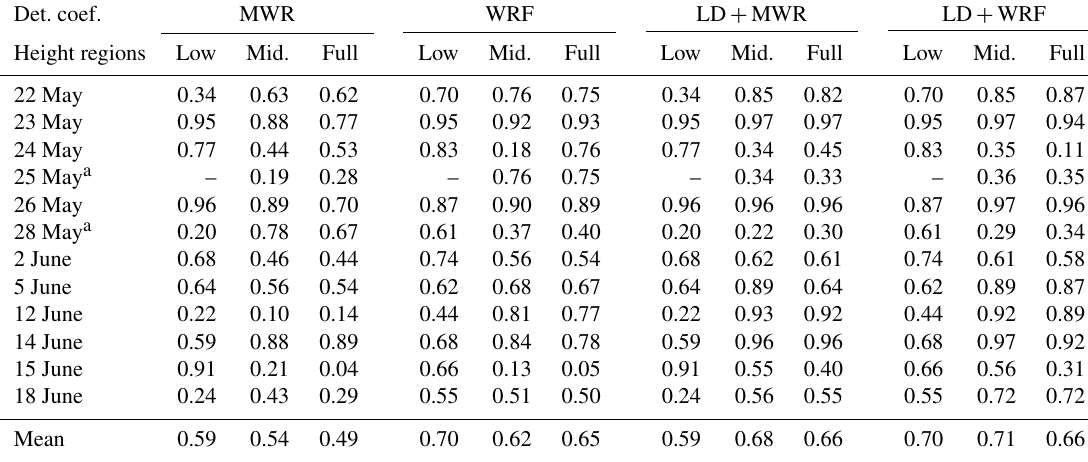
Table 4. Determination coefficients between various measurements techniques or simulations of relative humidity profiling and radiosound- ing for different height regions (low-resolution radiosounding cases). LD: lidar, MWR: microwave radiometer, WRF: WRF model. Det. coef. MWR WRF LD + MWR LD + WRF Height regions